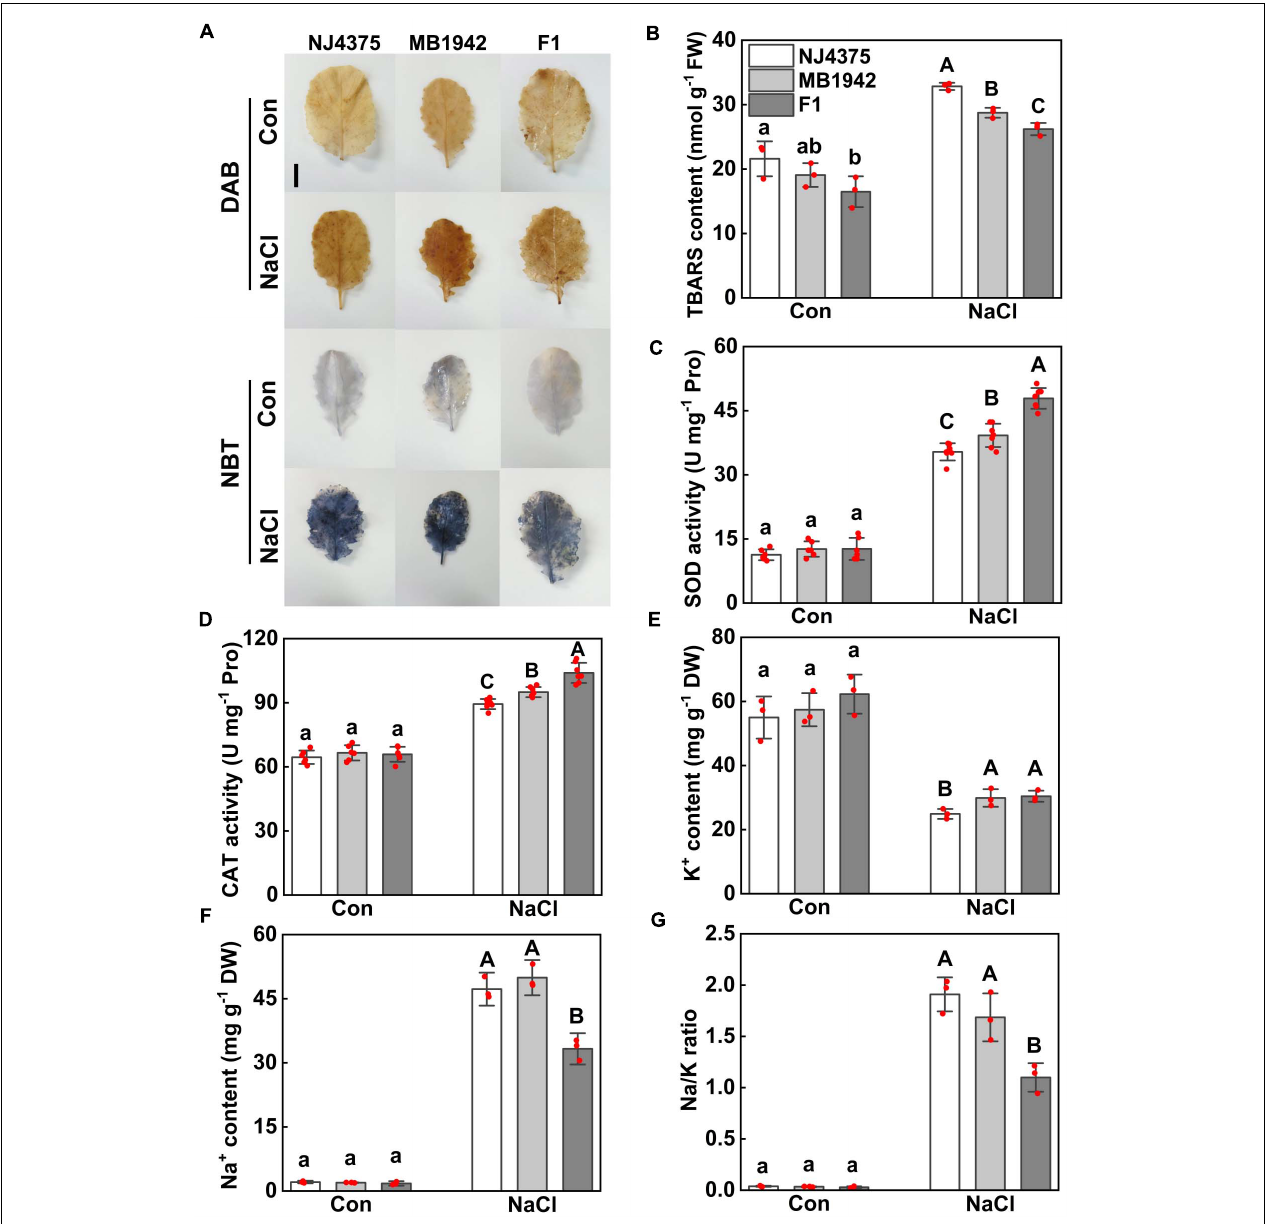
FIGURE 2 | Heterosis of B. napus hybrid (F1) and their parental lines (NJ4375 and MB1942) on alleviating oxidative damage and maintaining ion homeostasis. (A) Leaves were collected and stained with 3,3 (cid:48) -diaminobenzidine (DAB) or nitroblue tetrazolium (NBT) to visualize H 2 O 2 or O 2 − distribution, respectively. Bar = 3 cm. Meanwhile, TBARS content (B) , SOD activity (C) , CAT activity (D) , K + (E) , and Na + (F) contents, as well as Na/K ratio (G) in leaf tissues, were measured. Treatment with distilled water was regarded as control (Con). Values are the means ± SD for three or five independent experiments. One-way ANOVA analyses were conducted according to Duncan’s multiple range test. Within each set of experiments, bars with different letters denote significant differences at P <